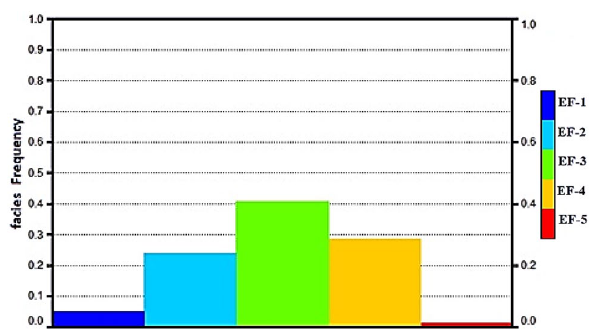
Fig. 9 Frequency plot of